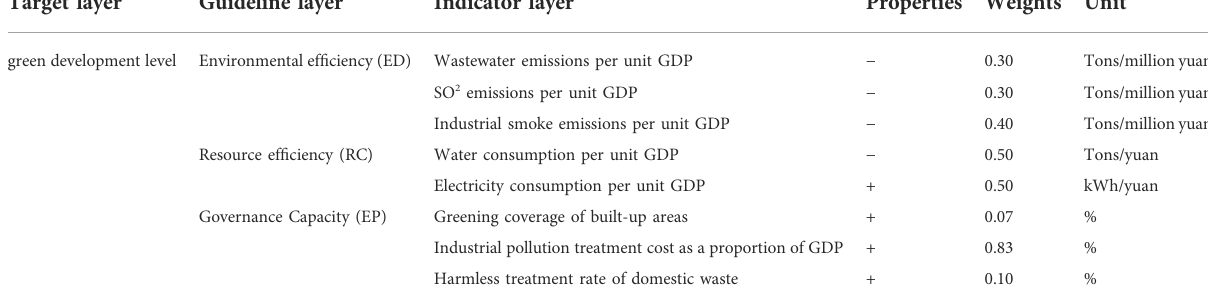
TABLE 3 Economic green development level evaluation index